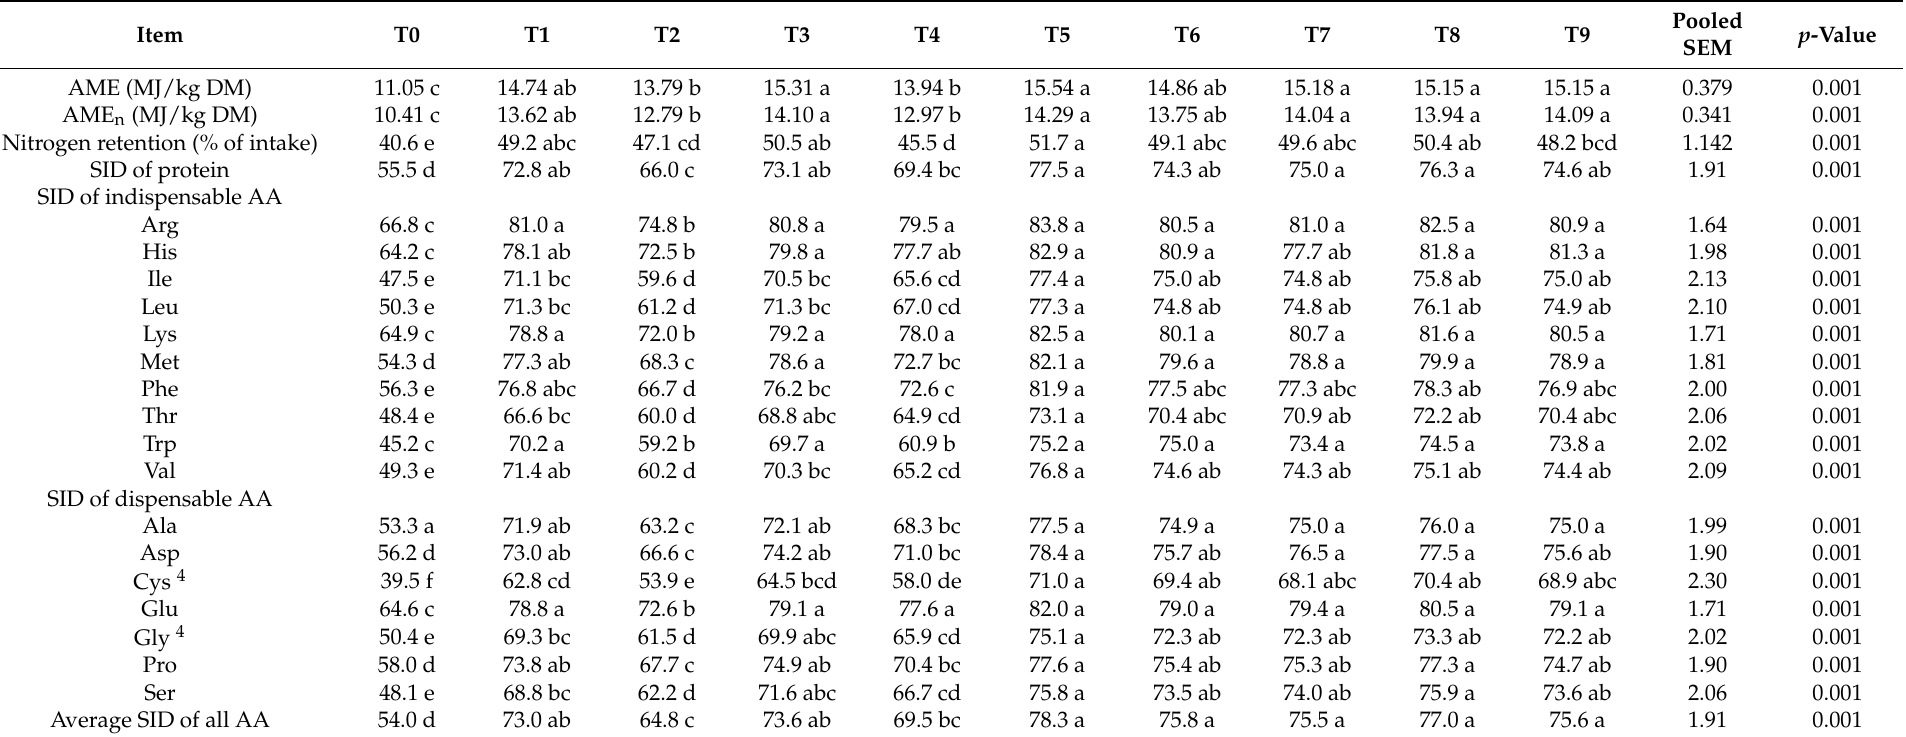
Table 6. The influence of heat treatments on the apparent metabolizable energy (AME), nitrogen-corrected AME (AMEn), nitrogen retention, and standardized